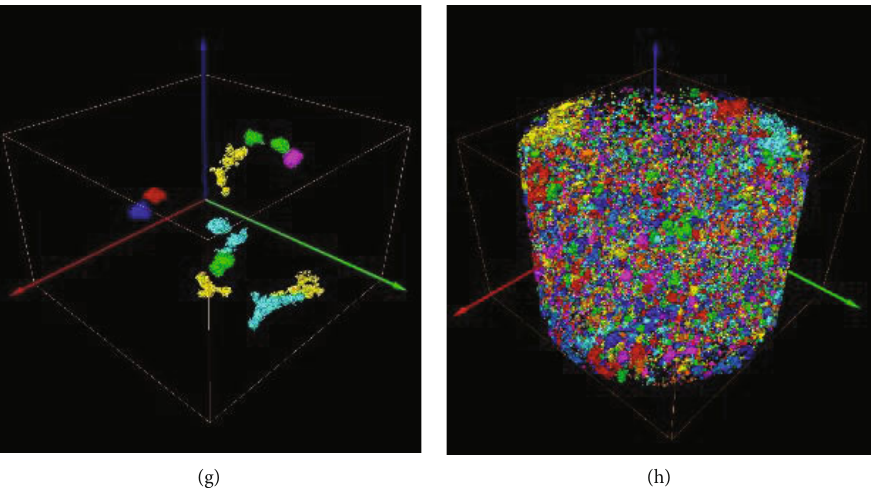
Figure 11: Three-dimensional graphics of pores with di ff erent pore sizes of q-1: (a) 9 μ m-18 μ m; (b) 18 μ m-36 μ m; (c) 36 μ m-72 μ m; (d) 72 μ m-144 μ m; (e) 144 μ m-288 μ m; (f) 288 μ m-576 μ m; (g) > 576 μ m; (h) > 9 μ